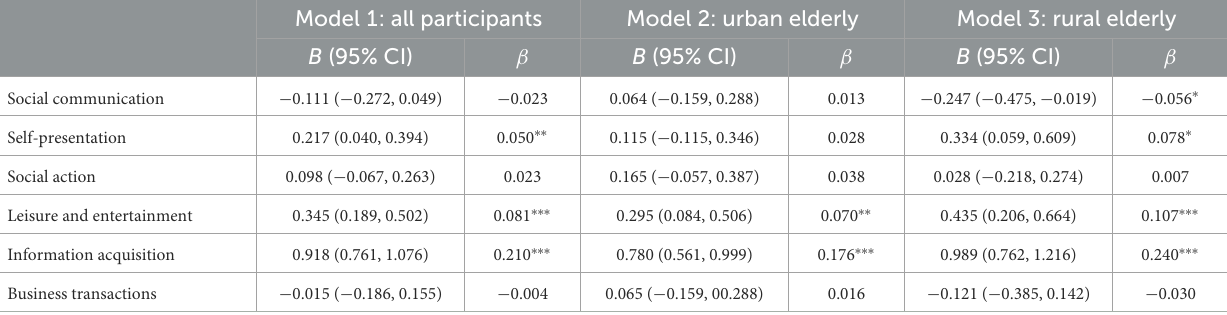
TABLE 3 Multiple linear regression analyses for the relations of six types of media use to health literacy. Model 1: all